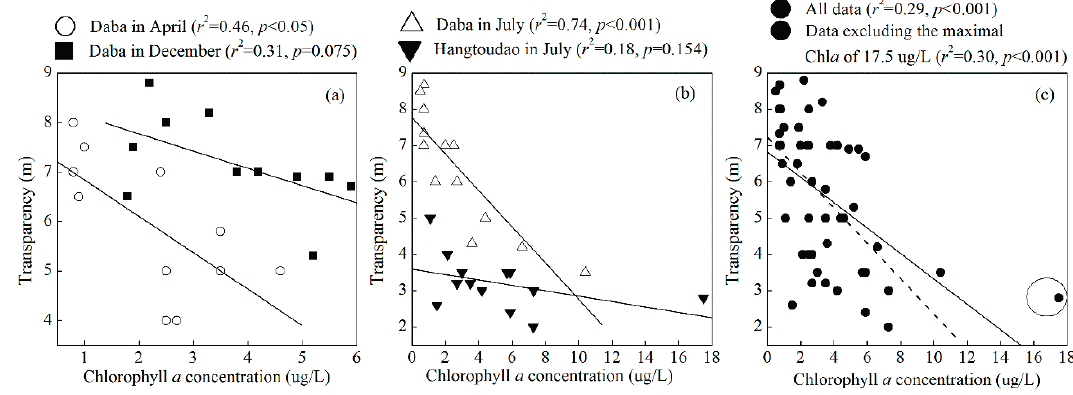
Figure 8. Correlations between the chlorophyll a concentration and the transparency from 2001 to 2013 in Xin’anjiang Reservoir. The dotted line shows the linear fitting excluding the maximal chlorophyll a of 17.5 µg/L as labeled in the